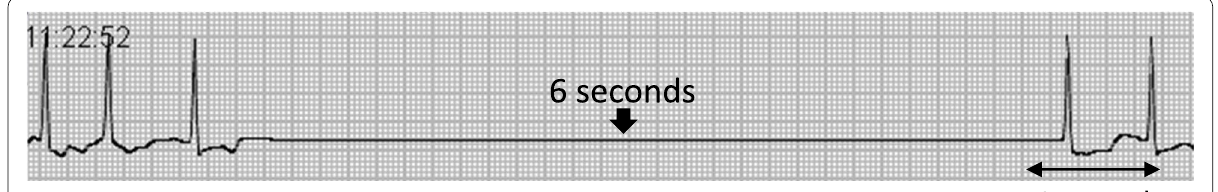
Fig. 2 ECG during detachment of the dura mater from the bone. During detachment of the dura mater from the bone, ECG suddenly showed sinus arrest for 6 s. Immediately after the manipulation was stopped, junctional rhythm